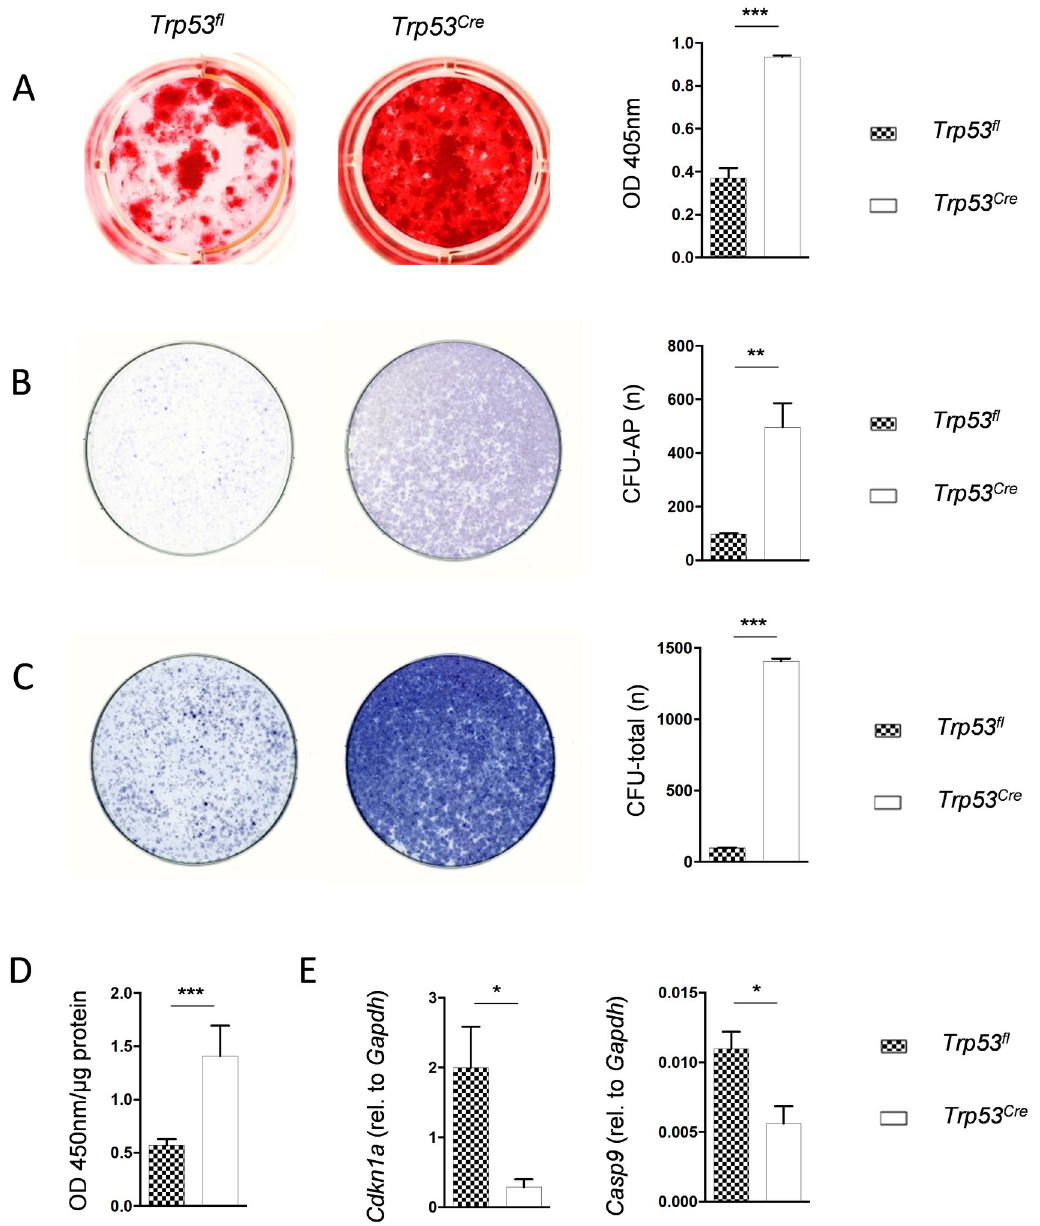
Fig 5. Trp53 Cre bone marrow cells display increased osteogenesis, colony formation and proliferation. (A) Representative images of cultured bone marrow cells from mice of the indicated genotypes, where mineralized matrix was stained by alizarin red at day 10 of osteogenic differentiation. Photometric quantification is shown on the right. (B) AP (alkaline phosphatase) activity staining of osteogenic colonies in cultured bone marrow cells from mice of the indicated genotypes two weeks after plating at low density. Quantification of the colony numbers is shown on the right. (C) Hematoxylin staining of all colonies in the same cultures. Quantification of the colony numbers is shown on the right. (D) BrdU incorporation assay in undifferentiated bone marrow cells from mice of the indicated genotypes. (E) qRT-PCR analysis for p21 and Casp9 expression, relative to Gapdh , in undifferentiated bone marrow cells from mice of the indicated genotypes. Data represent mean ± SD (n � 6). Asterisks indicate statistically significant differences ( � p < 0.05, �� p < 0.005, ��� p < 0.0005).